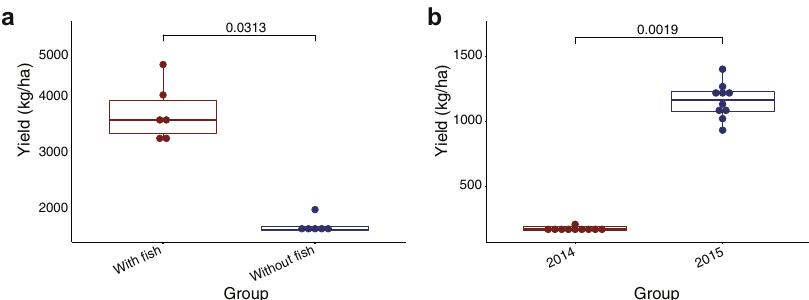
Fig. 4 Shrimp polyculture systems alleviate the poverty of small-scale farmers. a Total yield of P. monodon production in ponds with (red) or without grass carp (blue) at the farmers ’ association in Nansha, China. P -values (permutation test, paired) were labeled ( n = 6). b Total yield of F. chinensis production in ponds at the farmers ’ association in Tanghai, China, in 2014 (red) and 2015 (blue). Shrimp were cultivated without fi sh in 2014 and with fi sh in 2015. P -values (permutation test, paired) were labeled ( n =